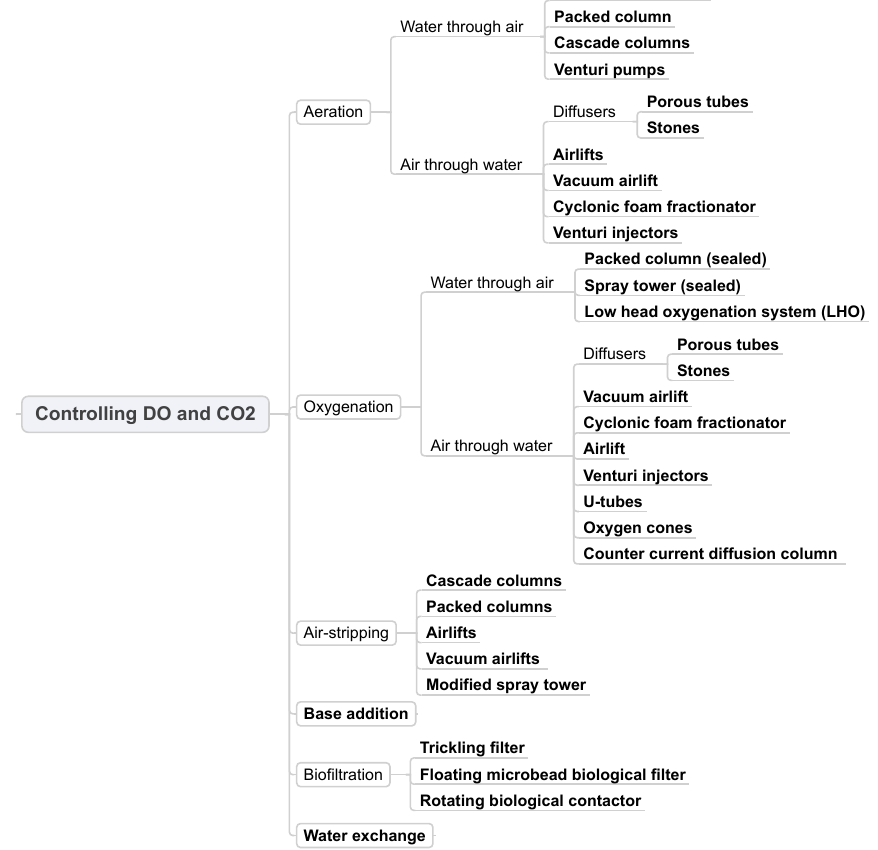
Figure 4. Taxonomy: controlling DO and CO 2